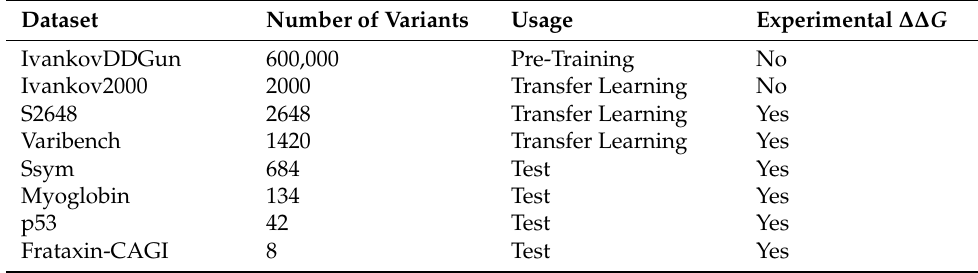
Table 1. Brief description of the datasets used. The table reports the number of variants available on each dataset, their usage in this study and whether or not the experimental ∆∆ G values are available. DDGun3D was used for the estimation of ∆∆ G s when they are not